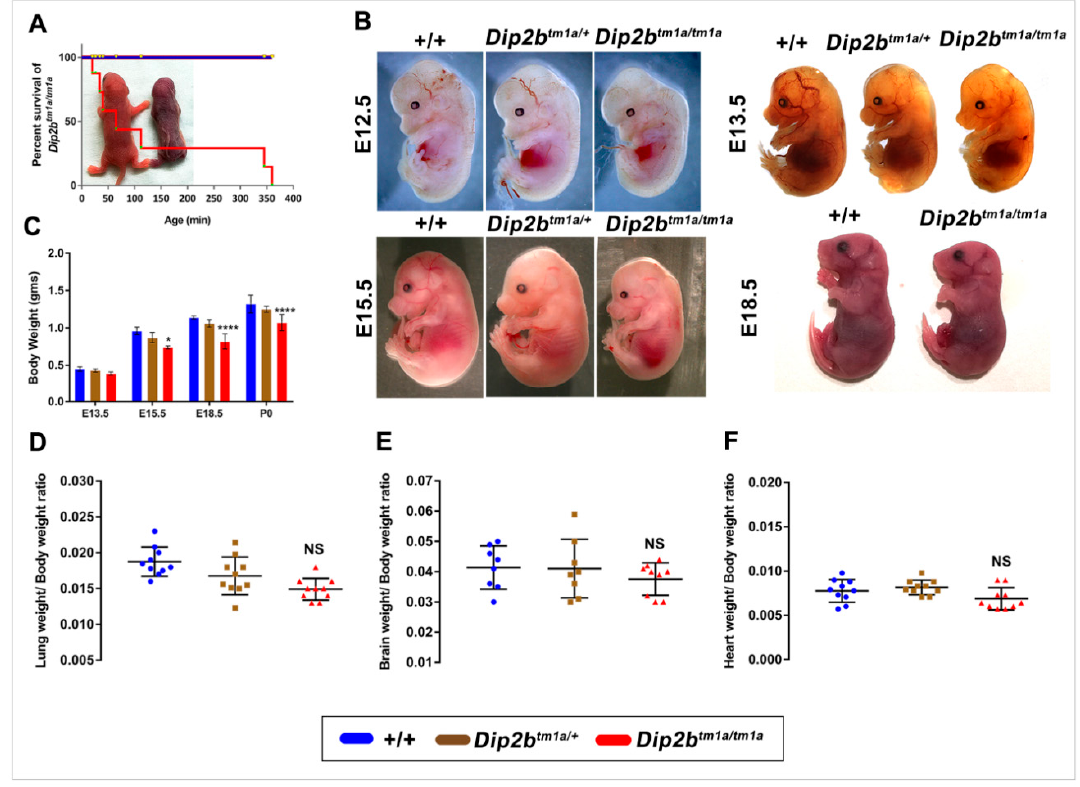
Figure 3. Phenotypical analysis: ( A ) Perinatal lethality in Dip2b tm1a / tm1a mice. Survival plot show significant lethality of Dip2b tm1a / tm1a mice at P0 ( p < 0.0001, n = 36). Background picture shows cyanosis immediately after birth; ( B ) Representative images of newborns; ( C ) Body weight at E13.5—P0; ( D – F ) Average weights (in grams) of brain, lung and heart at E18.5. Wet weights of organs were normalized to total body weight. * p < 0.05, **** p < 0.0001. NS, not significant.